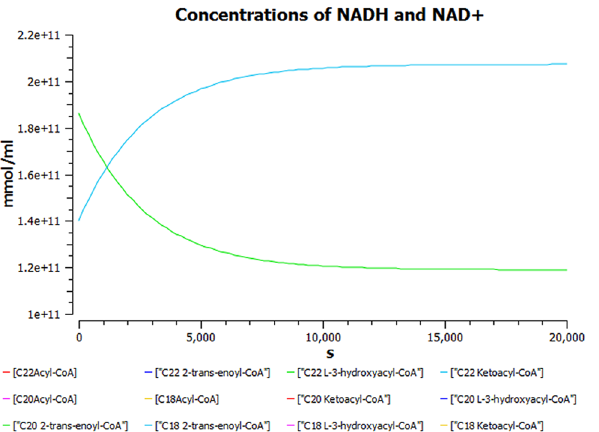
Fig 8. Free carnitine in diseased condition of uremia. (a): A 2D Bar chart depicting relative concentrations of Long Chain carnitine and Long Chain acyl-CoA in normal and diseased conditions. (b): A 2D Bar chart depicting relative concentrations of Long Chain acyl-CoAs in normal and diseased conditions. (c): A 2D Bar chart depicting relative concentrations of Long Chain carnitine in normal and diseased conditions. (d): A 2D Bar chart depicting relative concentrations of Long Chain acyl-carnitine and free carnitine in normal and diseased conditions. The results are in accordance with the disease condition of Uremia. (e): A 2D Bar chart depicting ratio of relative concentrations of Long Chain acyl-carnitine and free carnitine in normal and diseased conditions. The results are in accordance with the disease condition of Uremia.